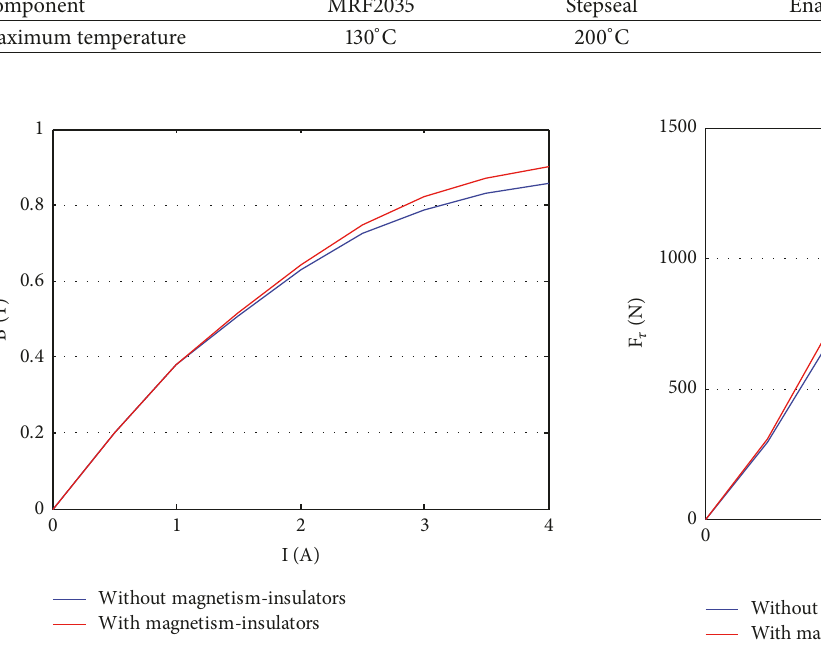
Figure 13: Average magnetic induction intensity in the damping gap.